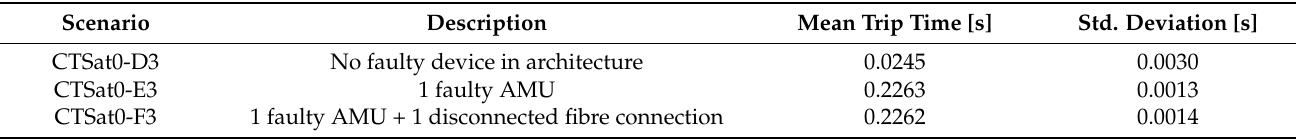
Table 11. Trip times for line-to-line